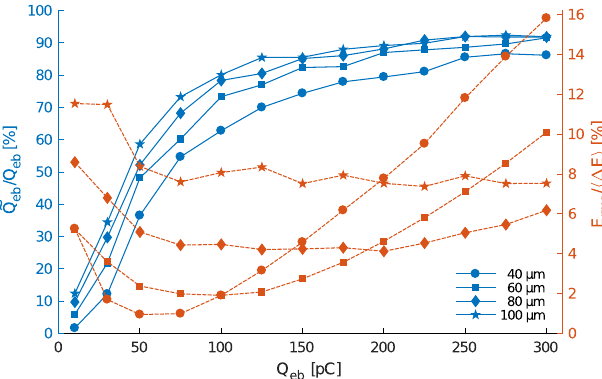
FIG. 7. Ratio of witness beam charge with emittance preserved, ~ Q=Q (blue symbols, lines), as a function of initial beam charge, and relative energy spread of the accepted charge (red symbols, dashed lines), after 4 m of plasma and with an initial emittance ϵ ¼ 2 μ m. These are shown for four different σ N ; 0 100 μ m. The detailed studies presented in beam loading section correspond to the square marked lines at 100